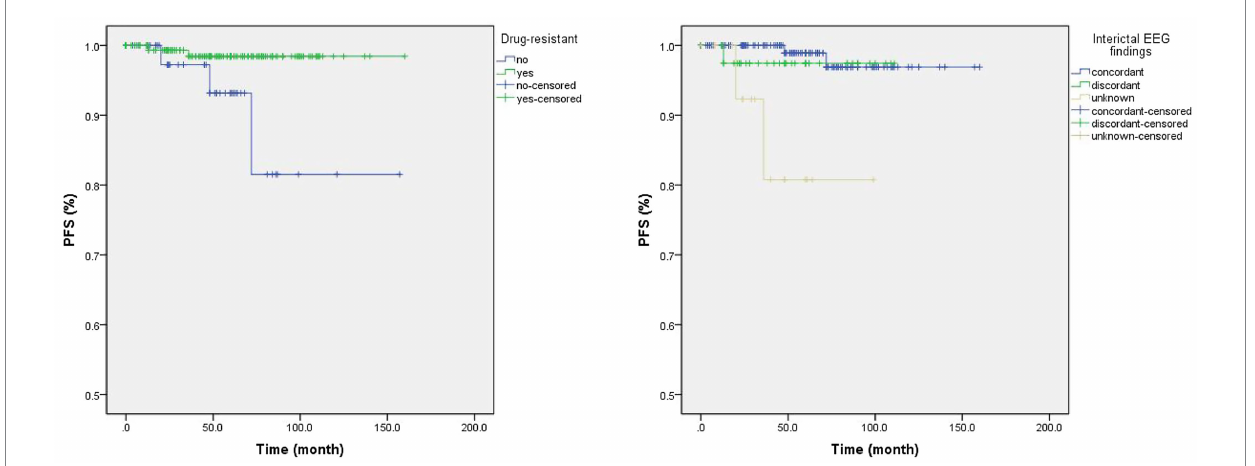
FIGURE 1 The Kaplan Meier curves of significant clinical factors in univariate Cox regression analysis. Patients with drug-resistant epilepsy were with a lower rate of tumor recurrence than those without drug-resistant epilepsy (Left; Log Rank test: χ 2 = 5.551, p = 0.018), as well as in patients with concordant interictal video electroencephalogram (EEG) findings when compared to those with unknown EEG findings (Right; Log Rank test: χ 2 = 11.76, p = 0.003).